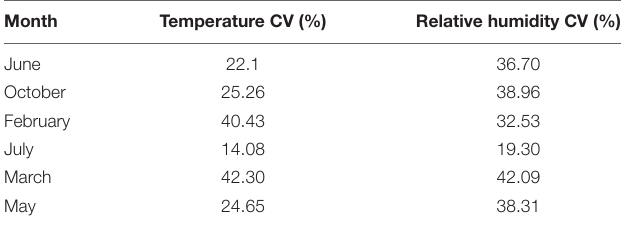
TABLE 1 | Coefficient of Variation for temperature-relative humidity data for estimating the variability of the